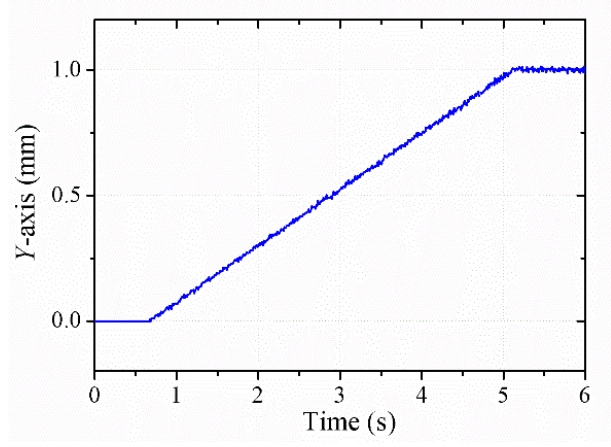
Figure 11. Motion behavior of machine tool acquired via Raspberry Pi.